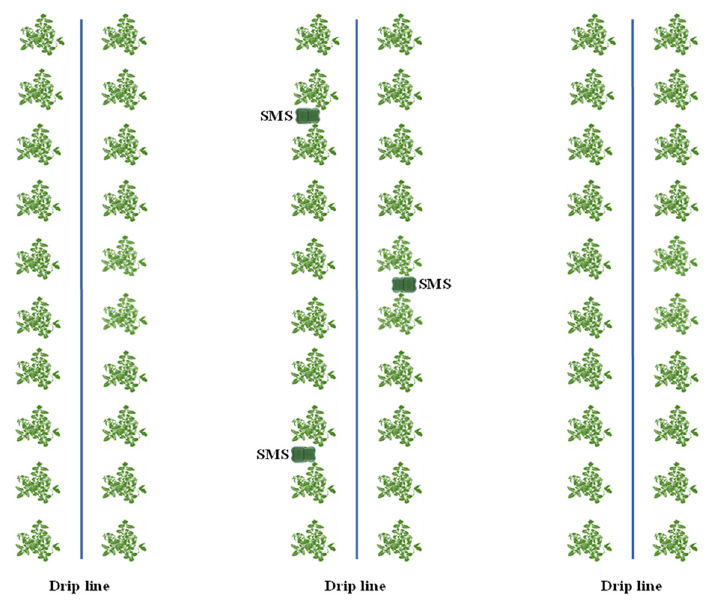
Figure 1. Location of wireless soil moisture sensors (SMS) halfway between plants along the central row of the plot.